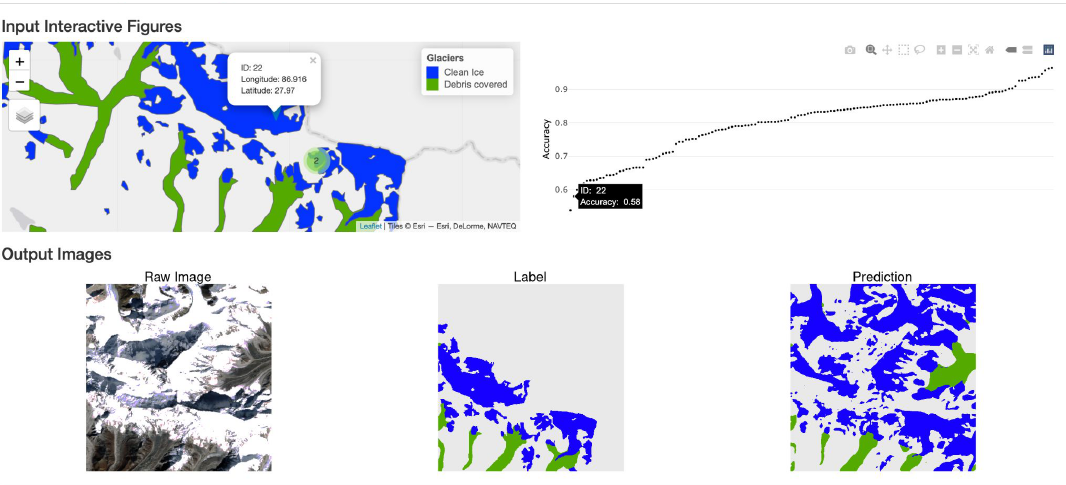
Figure 9. An example of prediction results with low accuracy. We notice that the prediction result actually matches the real label of the raw image well; however, the problem is that the label mask is incomplete, i.e., the upper right part is missing. Compared with the map, we find that the missing- label area is within the Chinese border. The glaciers within the Chinese border are not